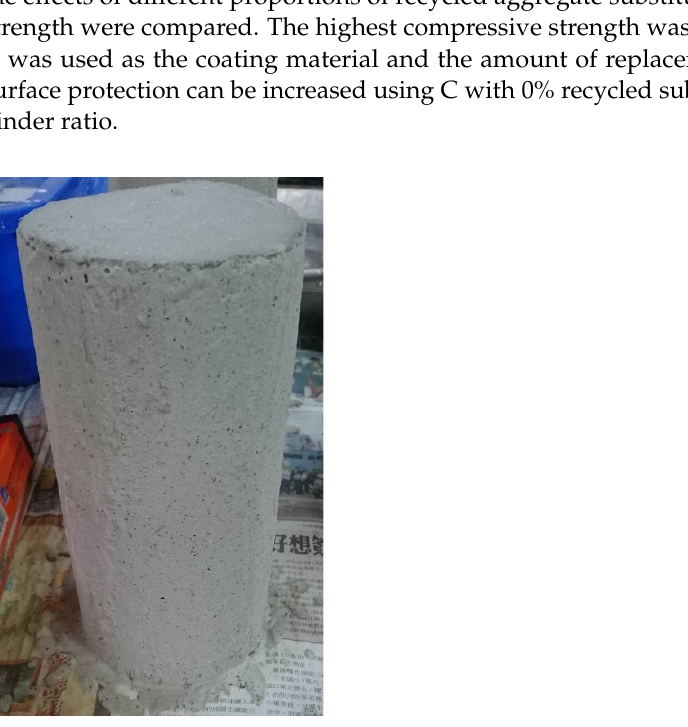
Table 4. Test variables.